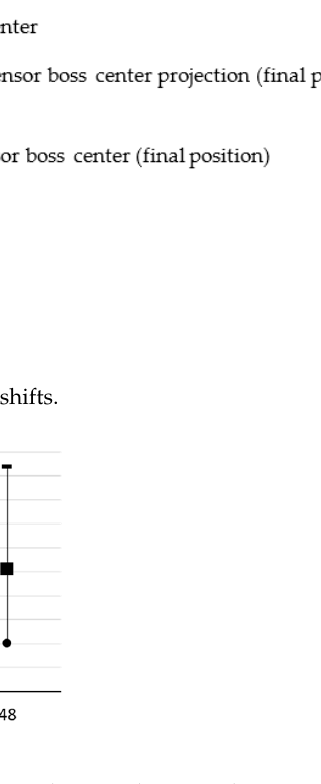
Figure 5. Experimental measurements for different distances between the camera and the sensor boss.